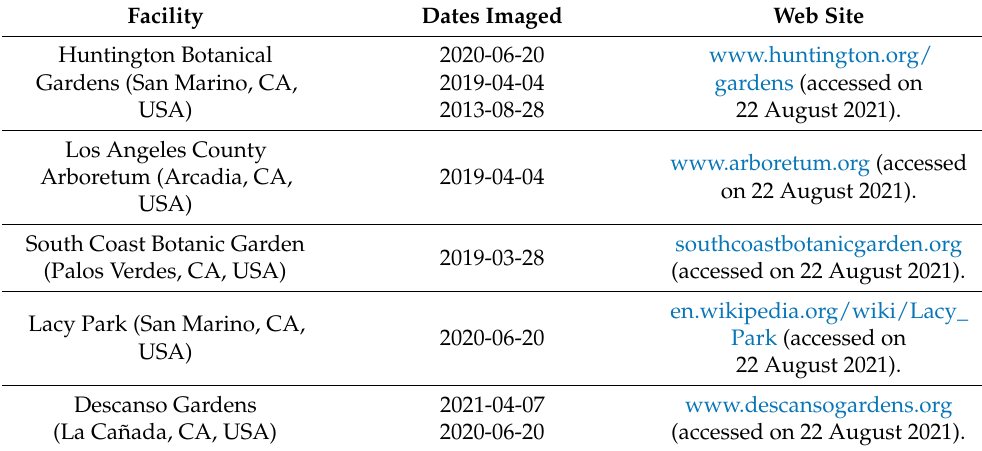
Table 2. Botanical collections contributing to this